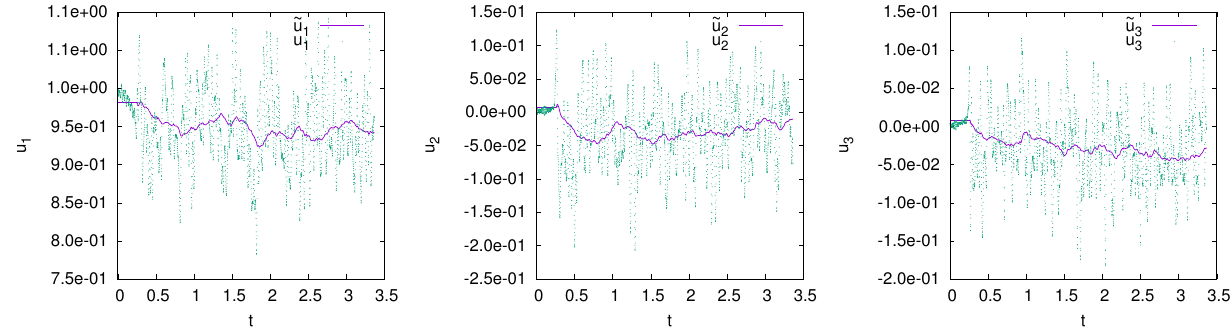
Figure 12. Probe no. 4: time series and time-bin average of the velocity components u 1 ( left ), u 2 ( center ), u 3 ( right ), evaluated by Equation